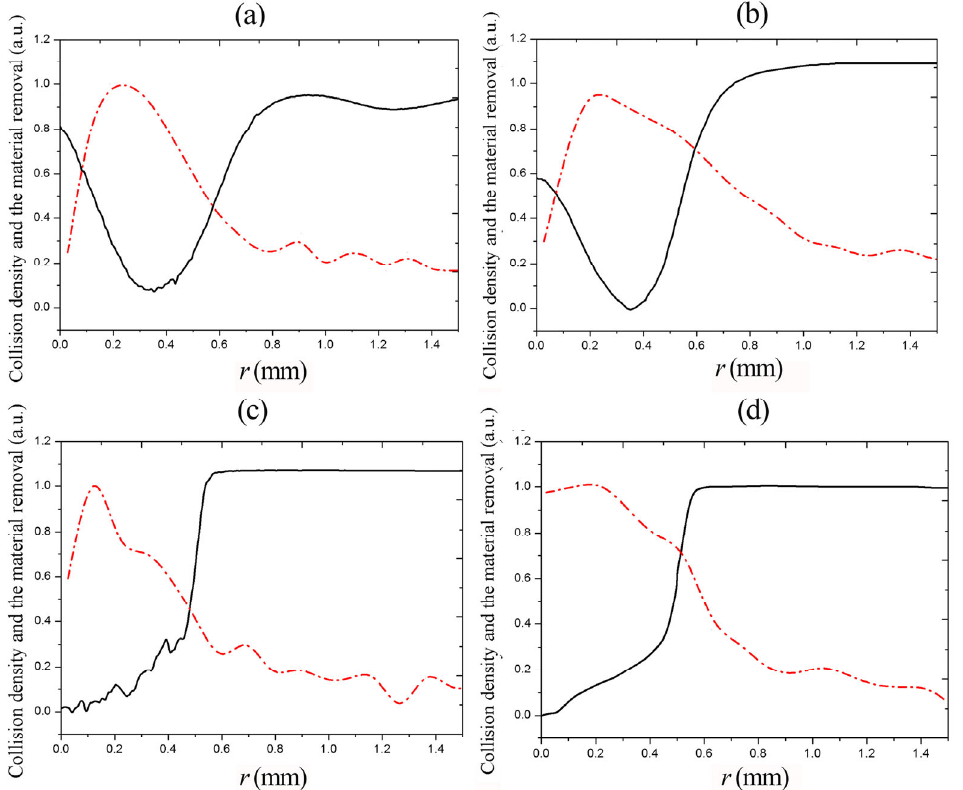
Fig. 4 Distributions of the observed material removal (solid lines in the pictures) and the calculated collision density (dashed lines in the pictures) on the impacted surface as a function of the radial position r . The abrasive particles are SiO 2 particles with a diameter of (a) 100 nm, (b) 500 nm, (c) 2 µm, and (d) 5